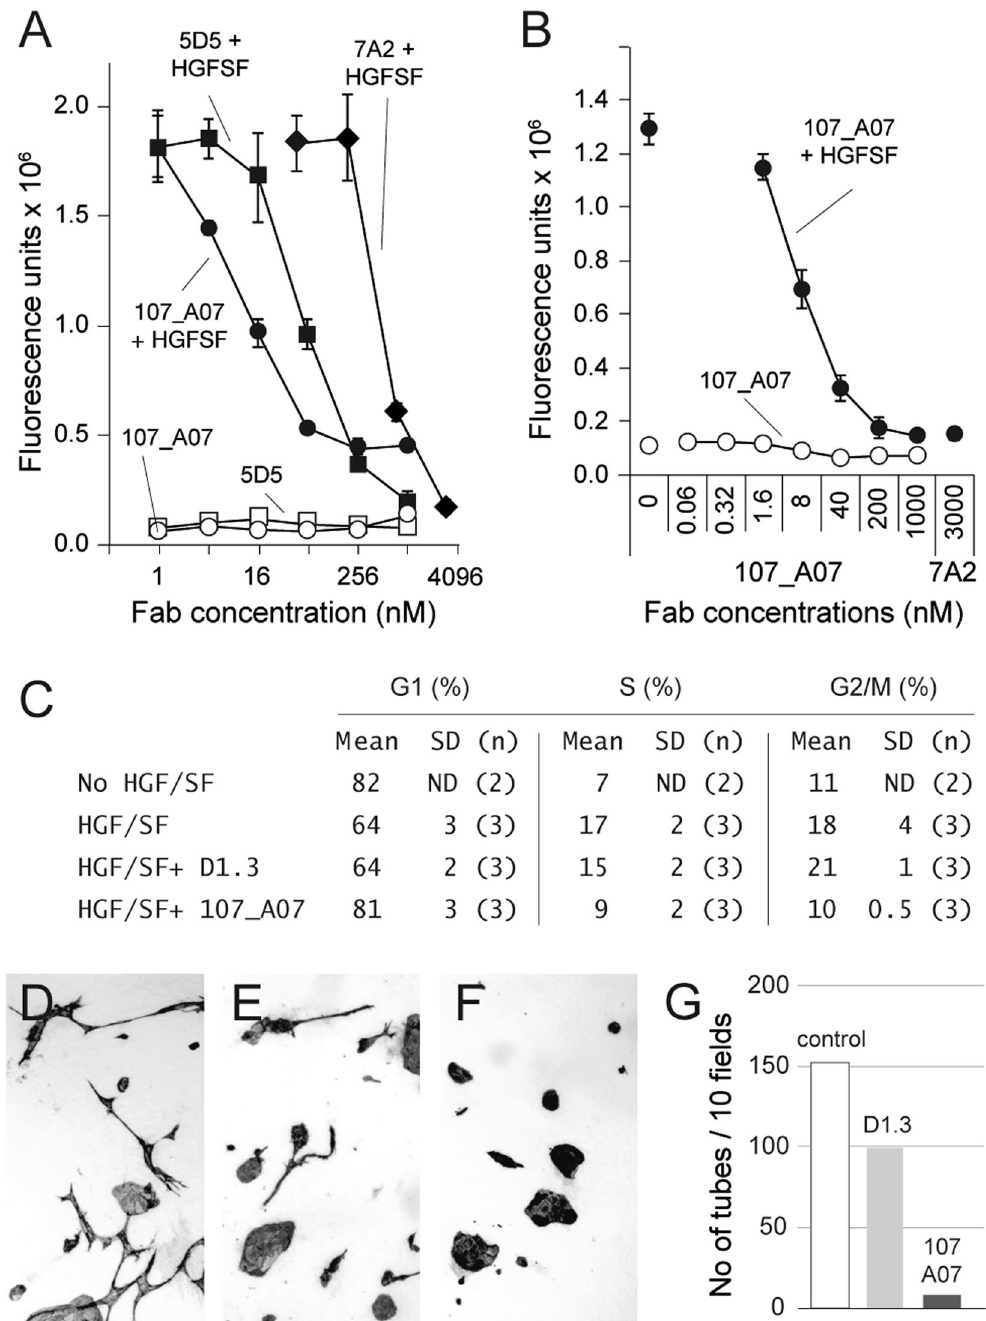
Figure 1. 107_A07 FAb inhibits HGF/SF-induced cancer cell migration, DNA synthesis and angiogenesis in vitro . Effect of parental Fab-formatted 7A2 and matured 107_A07 Fab on SKOV3 ( A ) and U87MG ( B ) cell migration in the presence and absense of HGF/SF in a modified Boyden chamber assay. A Fab-formatted version of the anti-MET antibody 5D5 was used as a control. Closed and open symbols show respectively the effect of antibody in the presence and absence of HGF/SF. Data represent mean ± standard deviation of triplicate wells. ( C ) Cell cycle analysis by propidium iodide staining of fixed, serum-starved U87MG cells 24 hours after exposure to 300 pM HGF/SF and/or Fab as indicated. Mean and standard deviation of (n) experiments are shown. ( D , E , F and G ) PEGylated 107A07 blocks angiogenesis in an in vitro angiogenesis assay in which co-culture with fibroblasts promotes endothelial cell sprouting and tubulogenesis. ( D ) control culture, no Fab, ( E ) PEG-D1.3 Fab, ( F ) PEG-107_A07 Fab, ( G ) quantification of endothelial tubules three days after the addition of